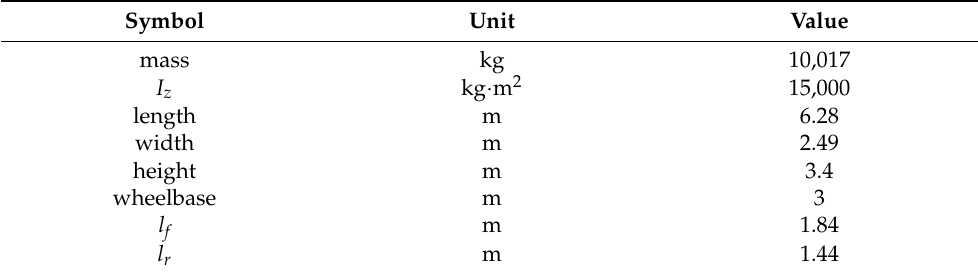
Figure 9. Path tracking performance comparison of three controllers for the U route. ( a ) trajectory; ( b ) lateral error.